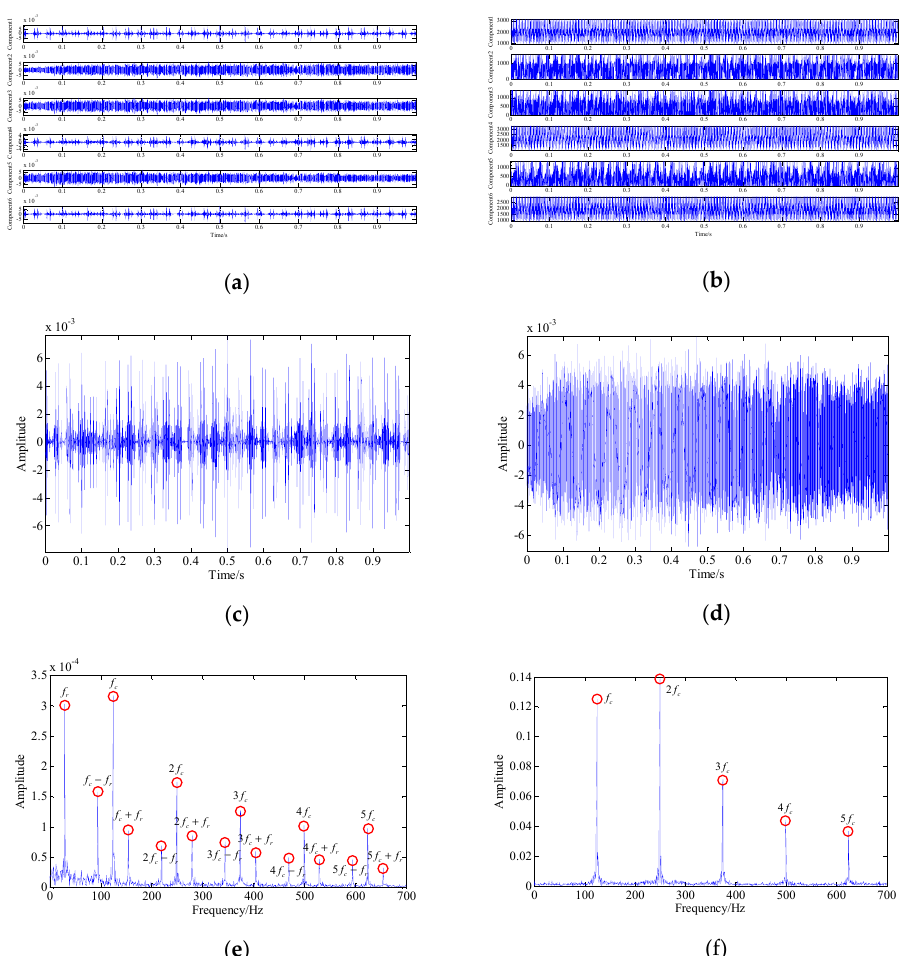
Figure10. Analysisresultsof theproposednoveldemodulation analysistechnique: ( a )waveforms ofthe one-dimensional single-component signals; ( b ) instantaneous frequency waveform of each component; ( c ) waveform of the extracted fault characteristic signal; ( d ) waveform of the extracted harmonic interference signal; ( e ) envelope spectrum of the extracted fault characteristic signal; ( f ) instantaneous frequency spectrum of the extracted harmonic interference signal.